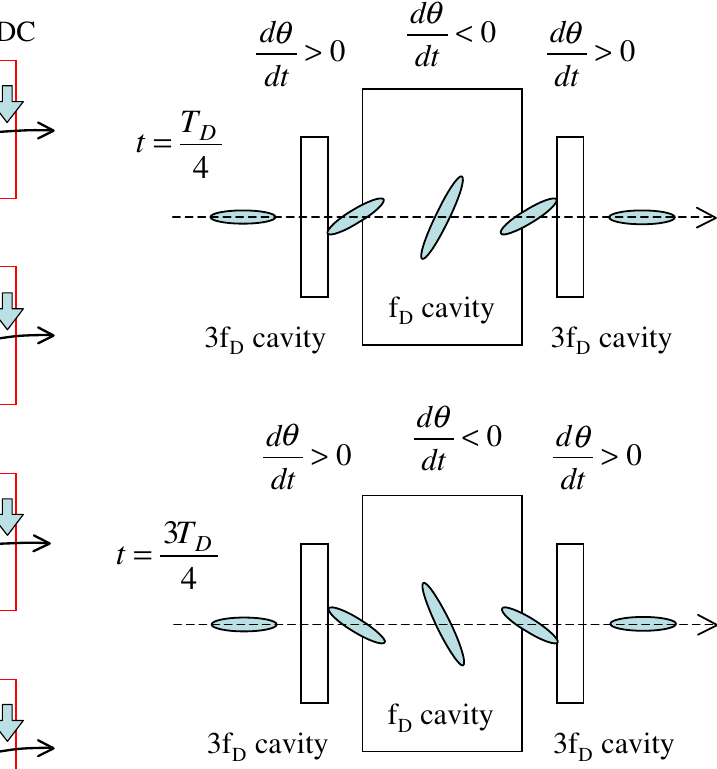
FIG. 7. (Color) Crab motion at cavity with frequency f cavities with 3 f system shown in Fig. 5. Motion of head and tail of bunch is also like a chicane.